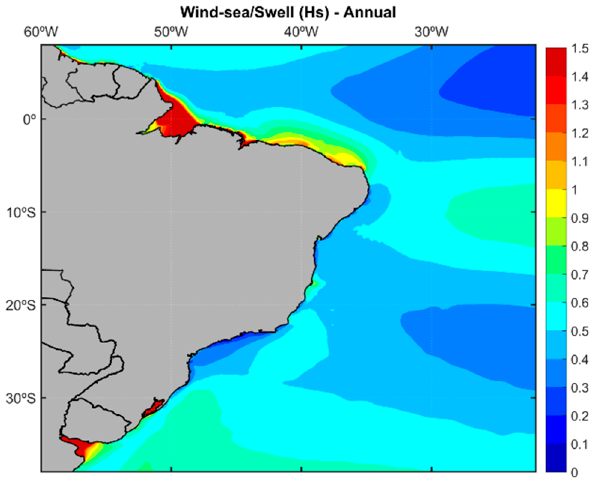
Figure 5. Annual mean swell prevalence based on H s (dimensionless) for Brazil.